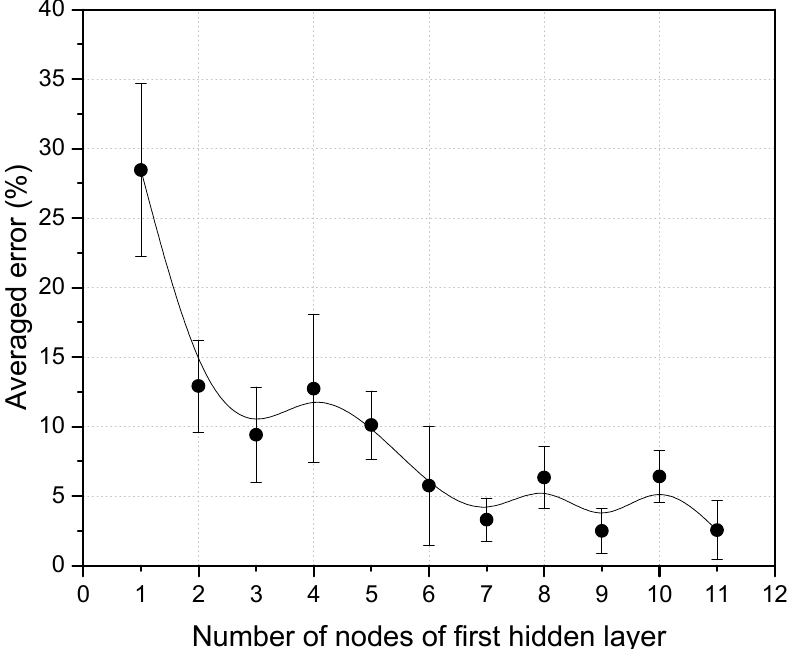
Figure 3. Averaged error between the experimental results and 3-layer ANN-trained results from 484 datasets obtained from eleven I–R experimental curves according to the variation in the number of nodes of hidden layers.